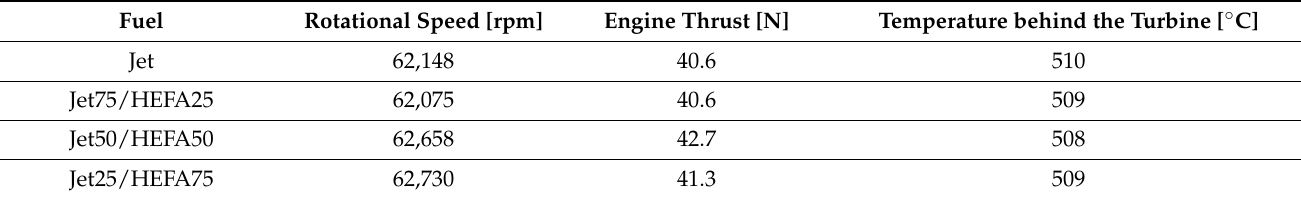
Table 3. Engine operating parameters during tests with different